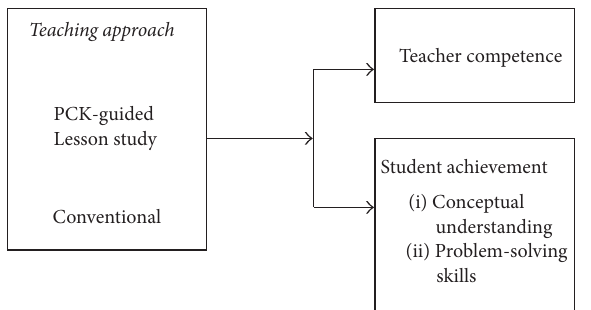
Figure 1: Conceptual